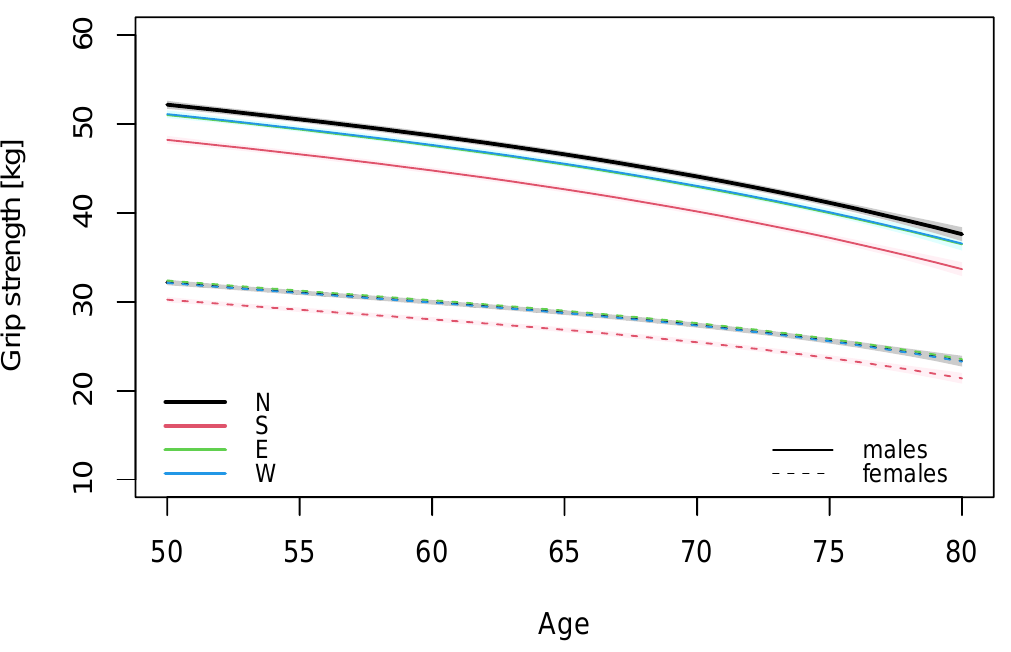
Figure 1. Predicted age-associated decline in grip strength for males and females with 95% confidence bands by region. Table 2. Multivariable regression model results for males and